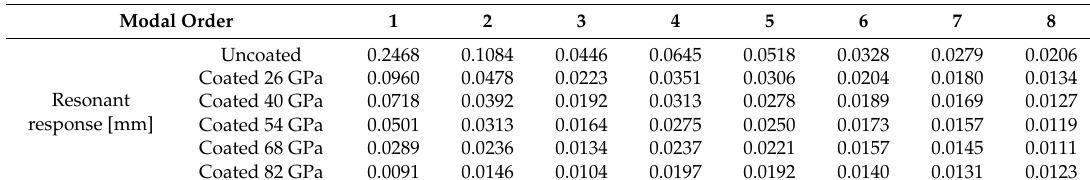
Table 7. The influence of elastic modulus of hard coating on the resonant response of the composite shell.